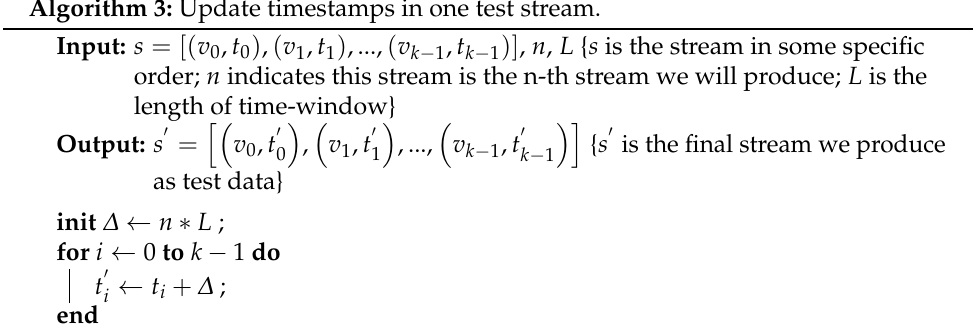
Algorithm 3: Update timestamps in one test